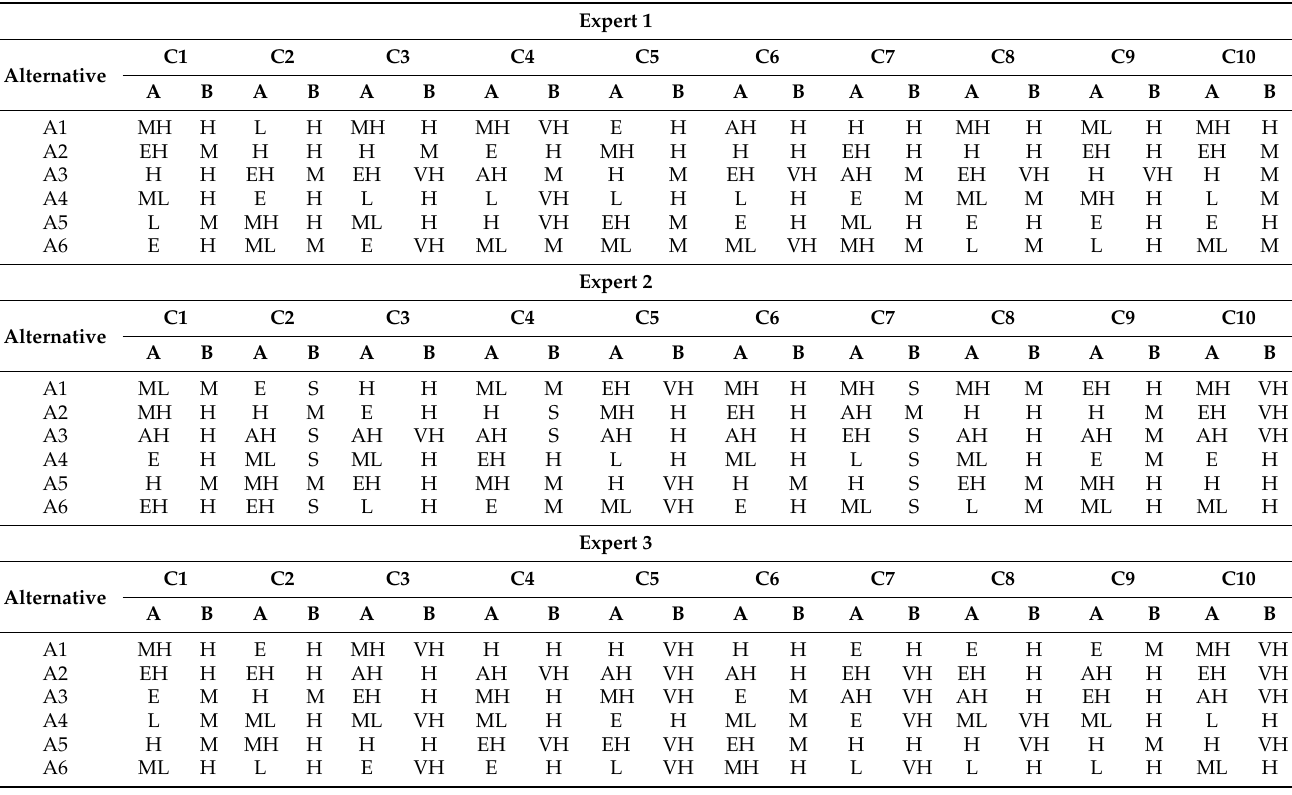
Table 7. Evaluation of alternatives by experts.